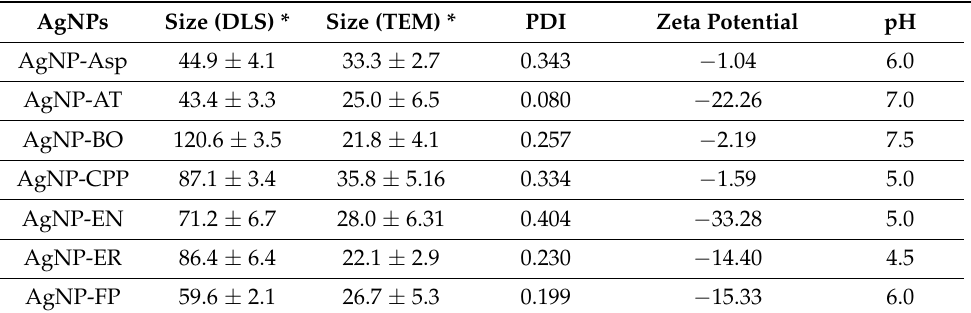
Table 1. Physicochemical properties of the AgNP-Asp, AgNP-AT, AgNP-BO, AgNP-CCP, AgNP-EN, AgNP-ER, and AgNP-FP: size (nm) by DLS and TEM, polydispersity index (PDI), zeta potential, and pH values. AgNPs Size (DLS) * Size (TEM) * PDI Zeta